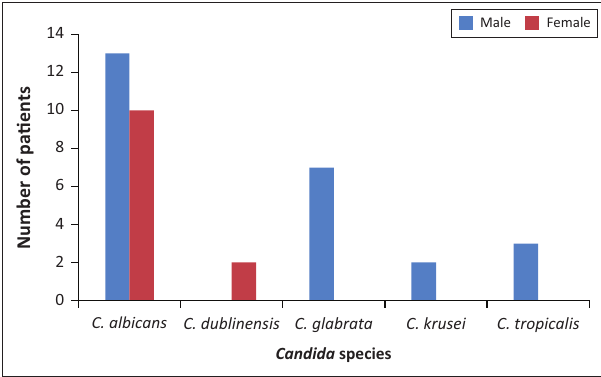
FIGURE 1: Distribution of Candida species by sex ( n = 37), Kampala, Uganda, March 2017 to December